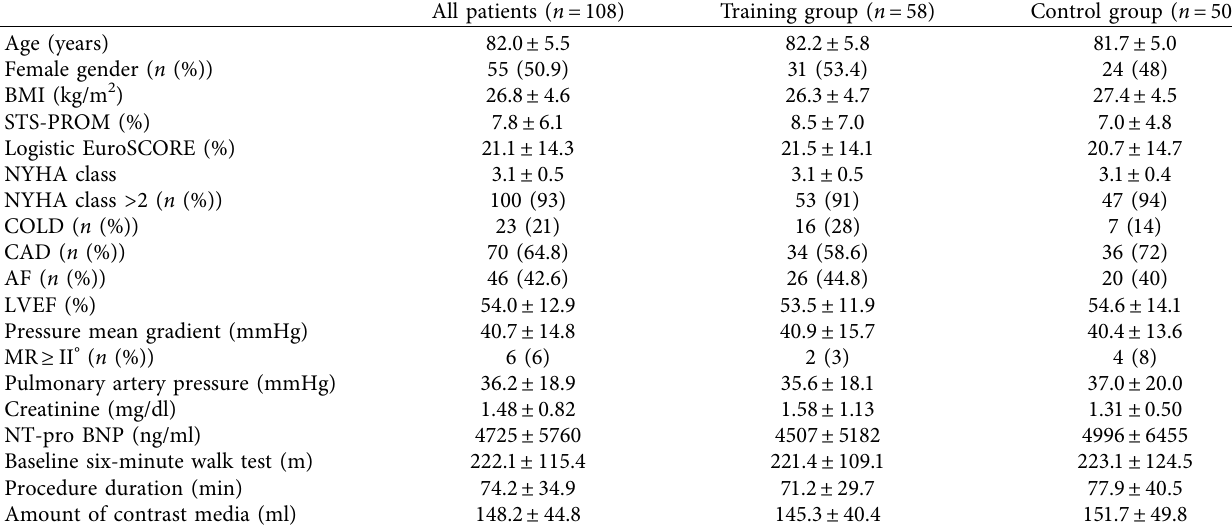
Table 1: Baseline